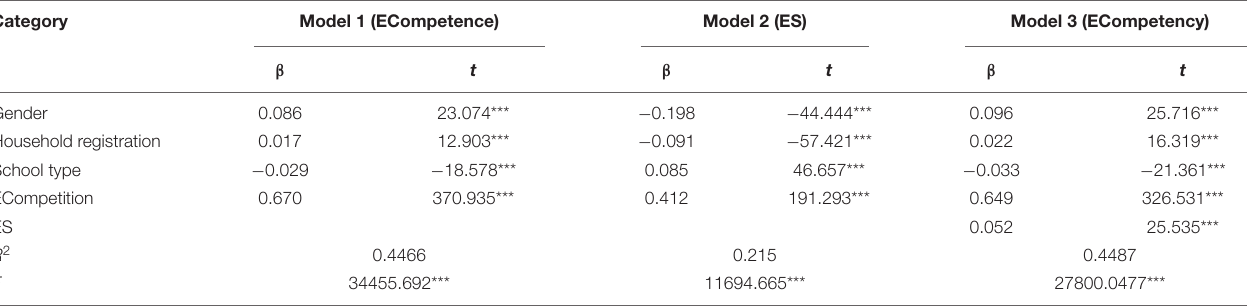
TABLE 4 | Mediating effect test of entrepreneurial spirit.